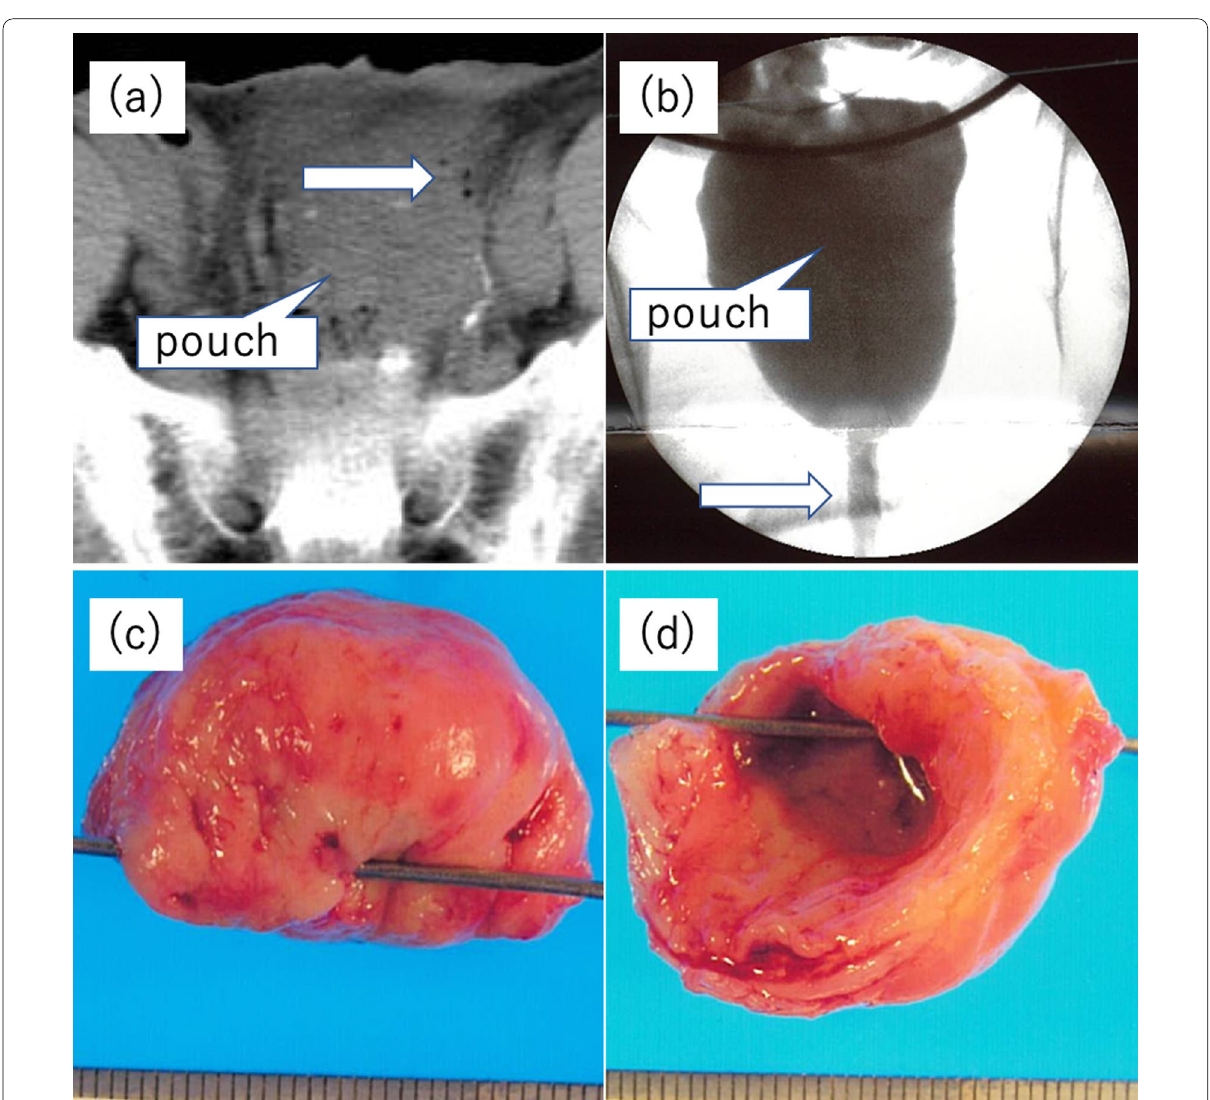
Fig. 1 Findings upon initial perforation. a Computed tomography. CT revealed free air and fluid collection around the blind end of the J-pouch (arrow), and perforation of the digestive tract was suspected. b Gastrointestinal gastrographic findings during surgery. Gastrointestinal gastrography revealed an anastomotic stricture. This appeared to cause an increase in the intraluminal pressure in the J-pouch. c , d Excised specimen findings. Gross appearance of the excised specimen. A 2-mm perforation was observed at the top of the blind end of the J-pouch. Inflammatory findings were observed on the serous surface ( c ). No ulcers were observed on the mucosal surface ( d